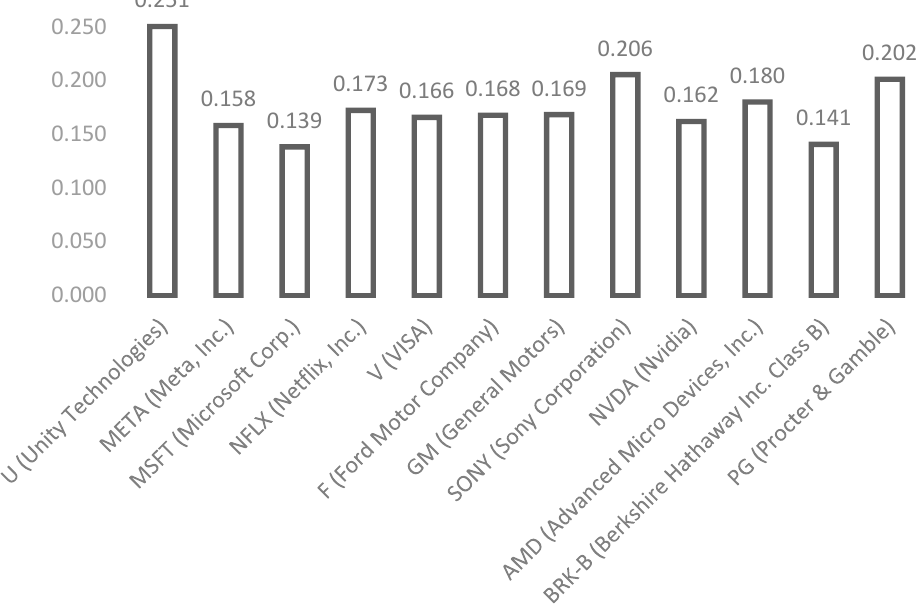
Figure 4. Stock price volatility in the analyzed period for the opening price.